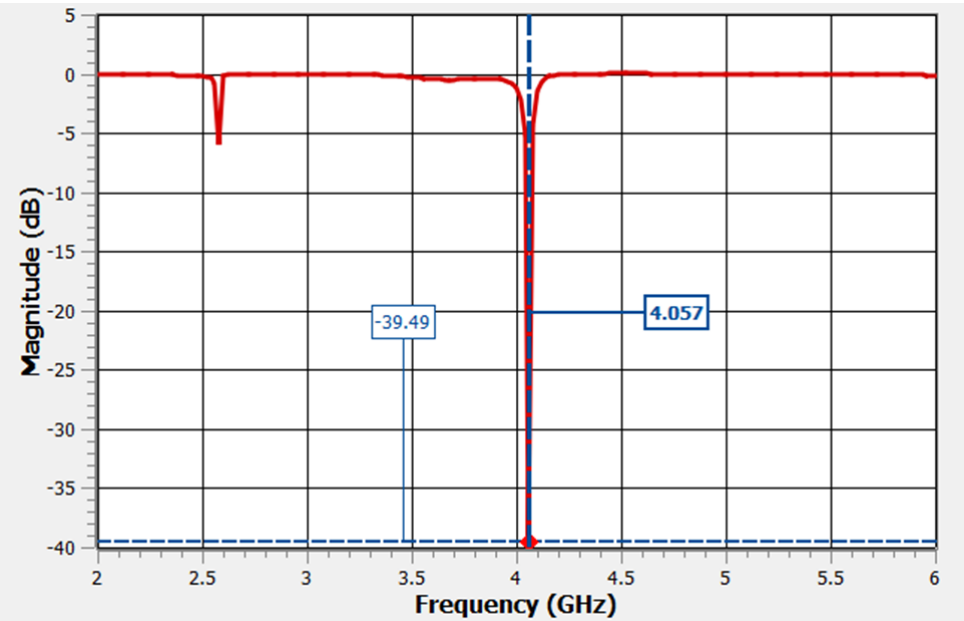
Figure 4. Graph of S11 reflection parameter